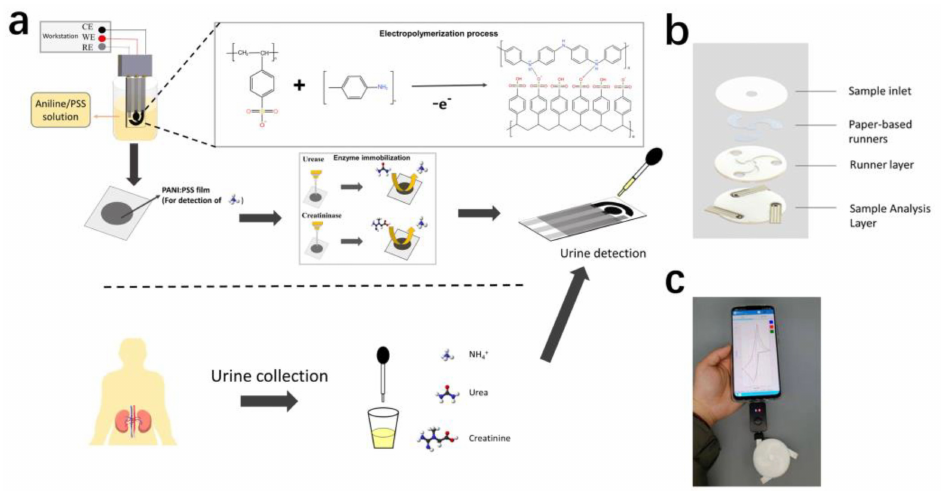
Figure 1. ( a ) The screen-printed electrode (SPCE) was modified with PANI: PSS to detect NH 4+ , and immobilized urease and creatinine deiminase to detect urea and creatinine in urine; ( b ) Urine multi-parameter detection sensor structure schematic; ( c ) Multi-parameter urine testing system, including smartphone, handheld electrochemical detection device, and this urine multi-parameter testing